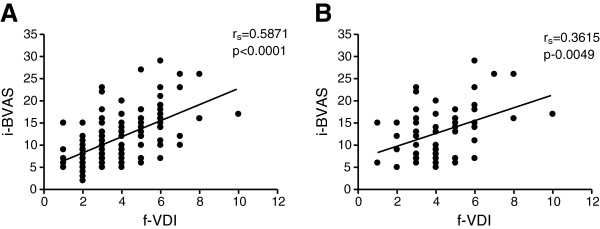
Association of BVAS scores at initial presentation (i-BVAS) with VDI scores at 2 years follow-up (f-VDI) in (A) non-pulmonary and (B) pulmonary involvement groups. Spearman’s correlation coefficient rs and p-value [95% CI] included in the analysis.